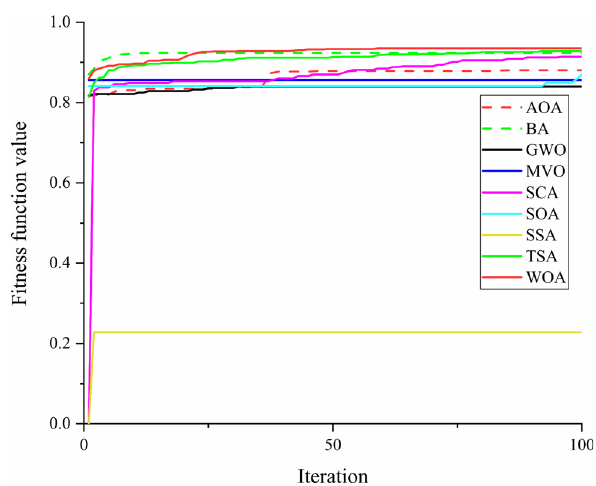
Fig. 10 The evolution curves of the algorithms for case 4